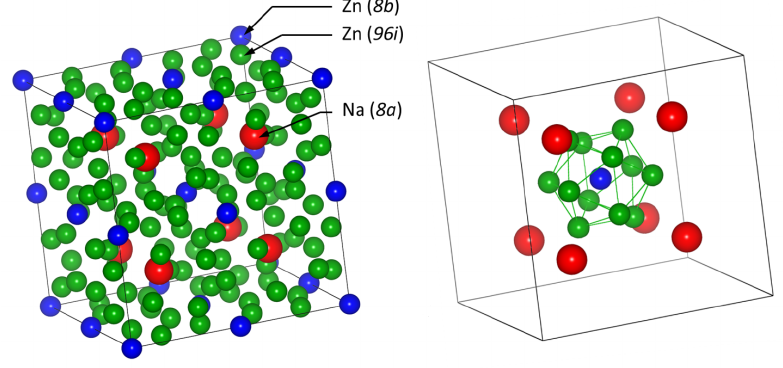
Figure 1. The crystal structure of the cubic NaZn 13 phase. The La atom occupy the 8 a sites (Na), whereas the Fe atoms are located on the 8 b and 96 i sites (Zn). In the right figure: one Fe (8 b ) atom is surrounded by 10 Fe (96 i ) and 8 La (8 a ). The Si atoms are substituted in the 96 i position. All of the La(Fe 1 − x Si x ) 13 compounds are ferromagnetic. The Curie temperature T C monotonously increases from 200 to 260 K for 0.1 < x < 0.21, and then